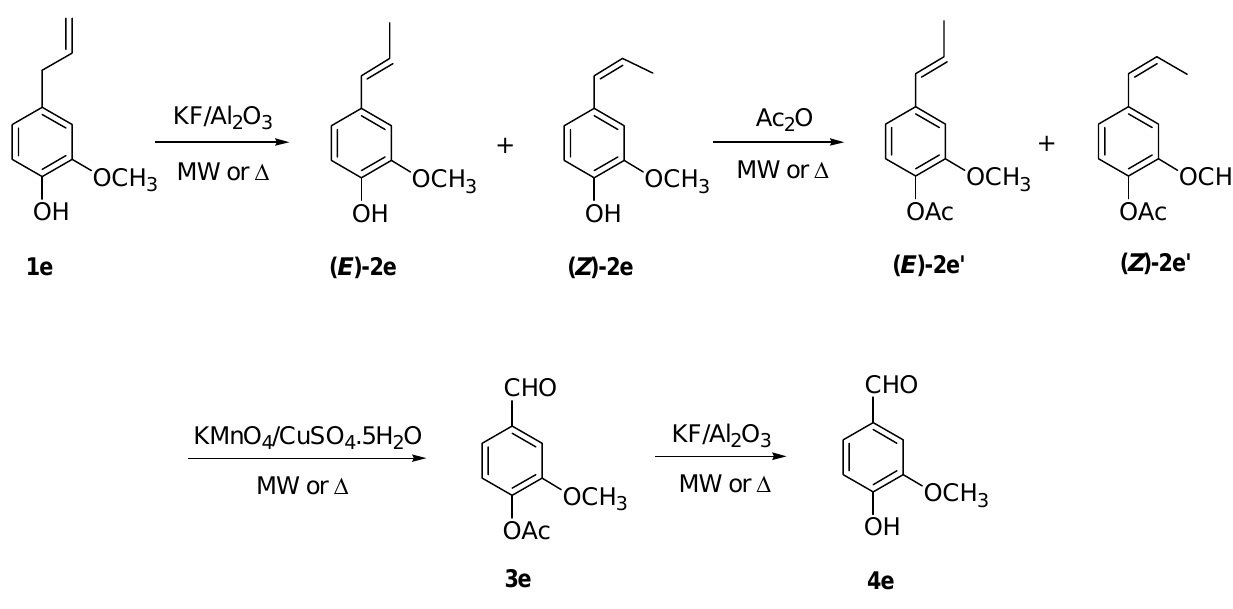
Scheme 2. Conversion of eugenol into vanillin under solvent-free